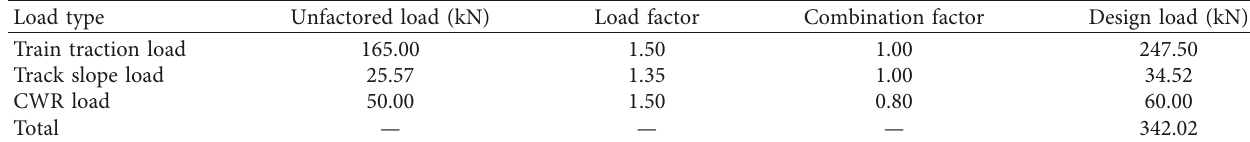
Table 1: Longitudinal design load ( P l ) on a quick-hardening track segment.